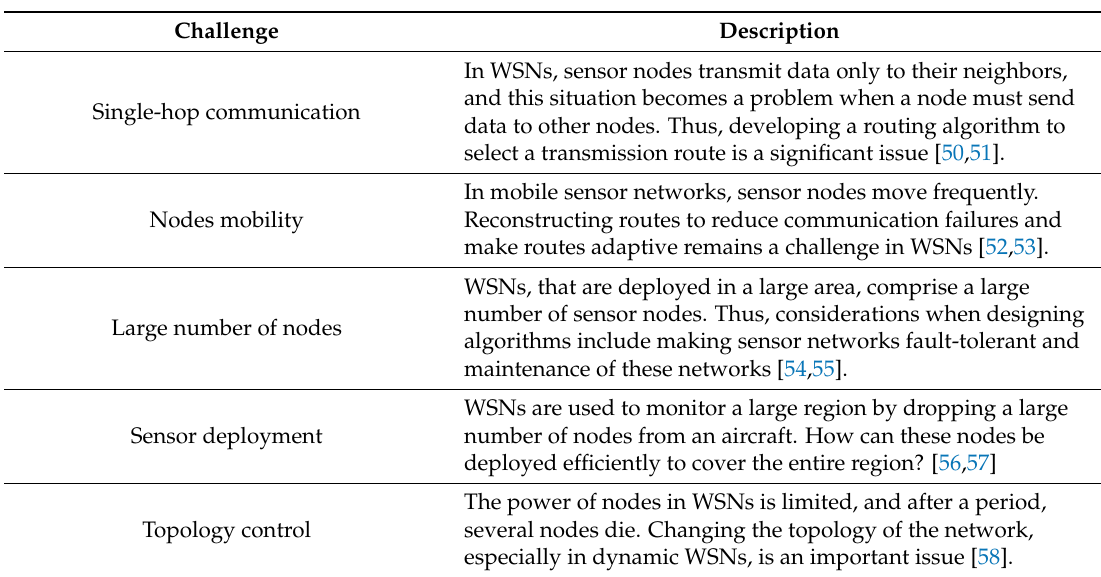
Figure 2. Sensor node’s components.